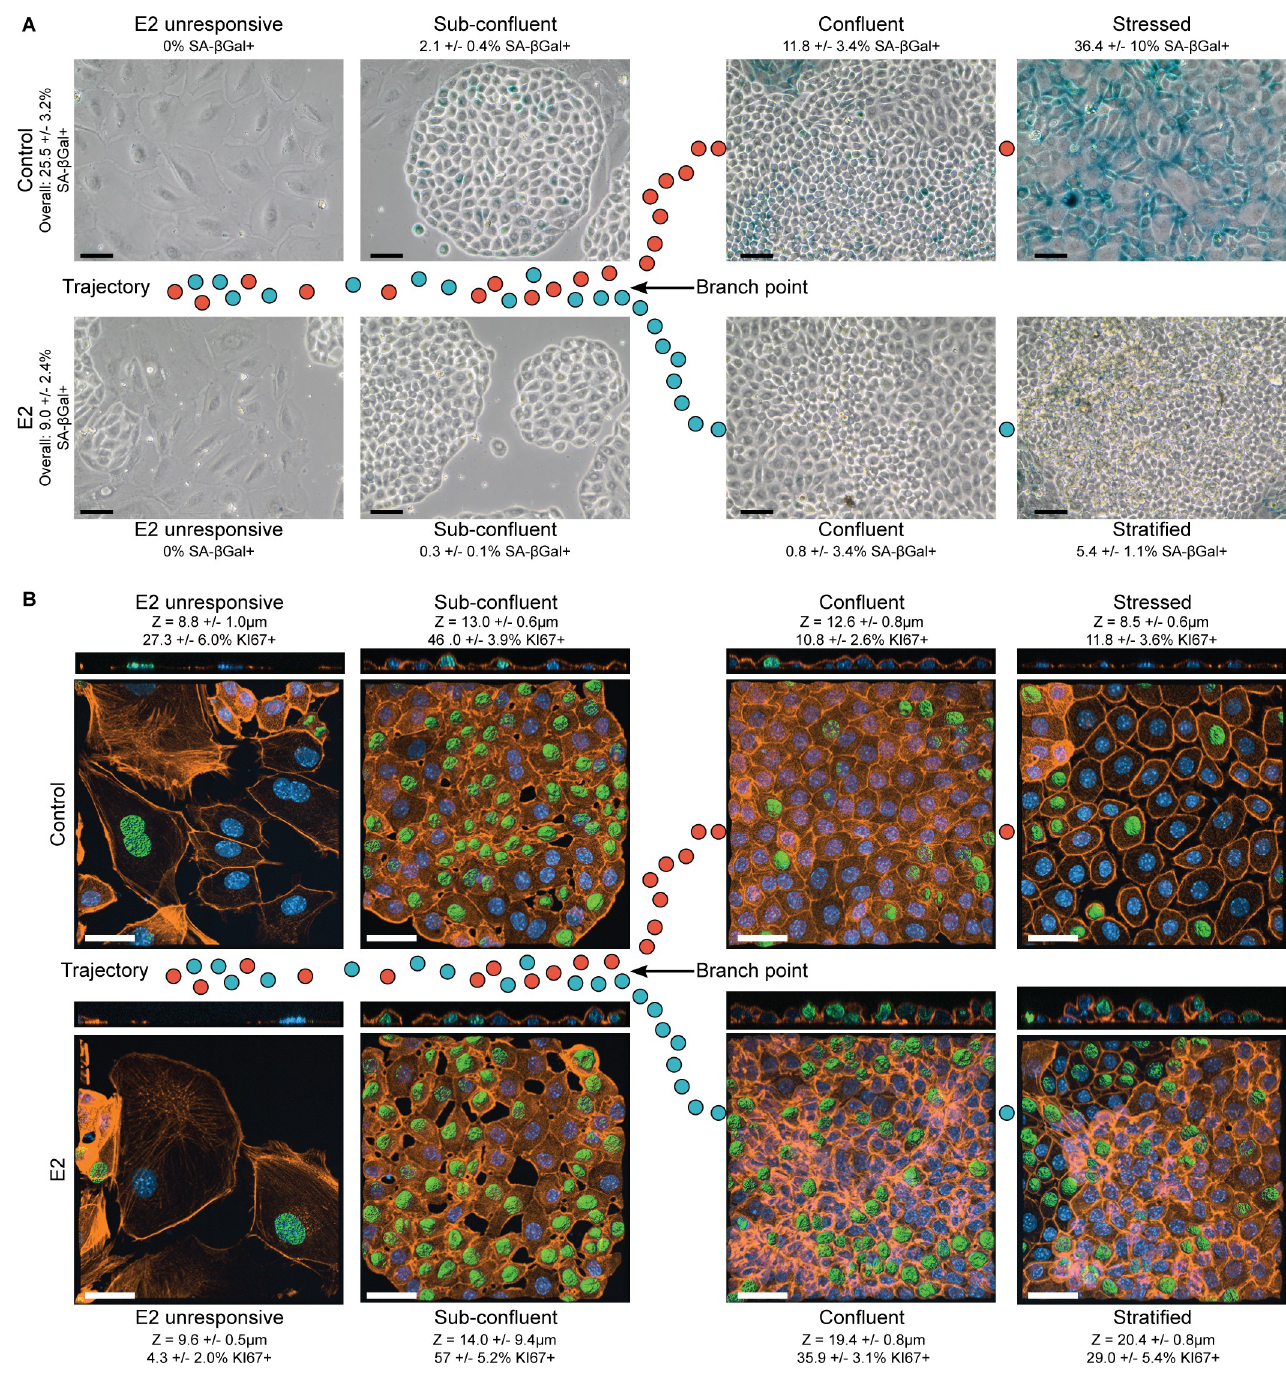
Fig 6. E2 promotes survival and proliferation. Control and E2-treated OSE cells stained for SA- β gal (A) and KI67 by IF (B). (A) Overall %SA- β gal, n = 7 using 4x objective; %SA- β gal/morphology, n = 6–7 using 40x objective. Scale-bar = 50 μ m. Representative images shown is a result of phase-contrast overlaid with bright-field. (B) Green = KI67, orange = Actin, blue = DAPI. %KI67+ = KI67+nuclei/DAPI; n = 6. Z = cell height; n = 5–6. Scale-bar = 30 μ m. Representative images display z-stack maximal intensity projections of Actin and DAPI channels merged with KI67 surface rendering. Axial view of field is also shown. (A-B)